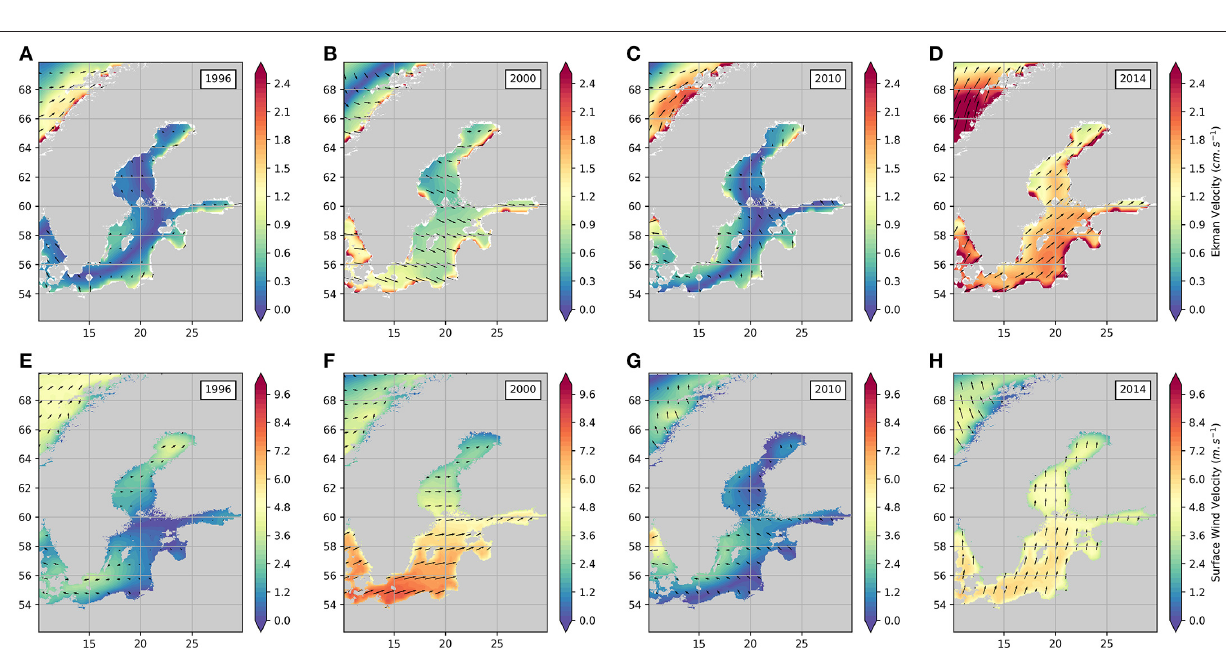
a 1/4 of a degree grid and they are derived using wind stress from ECMWF, Argo floats and in-situ surface drifter